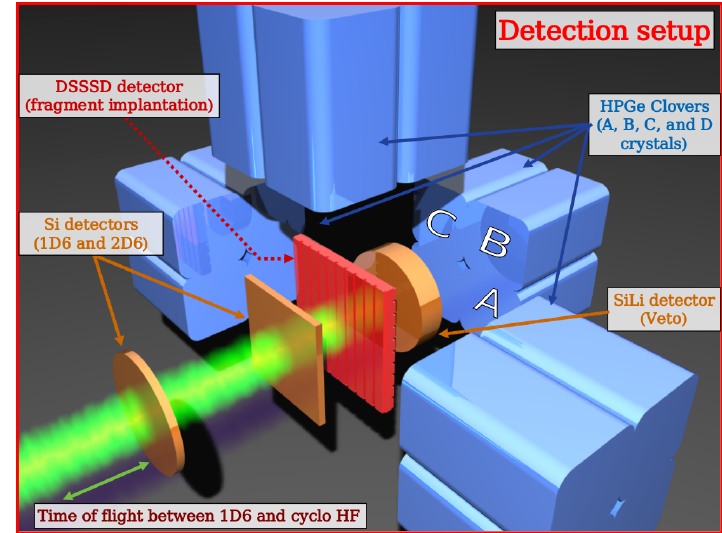
Figure 1. Detector array diagram. The HPGe clovers are depicted in blue, the Si and SiLi detectors in orange and the DSSSD in red. Image modified from